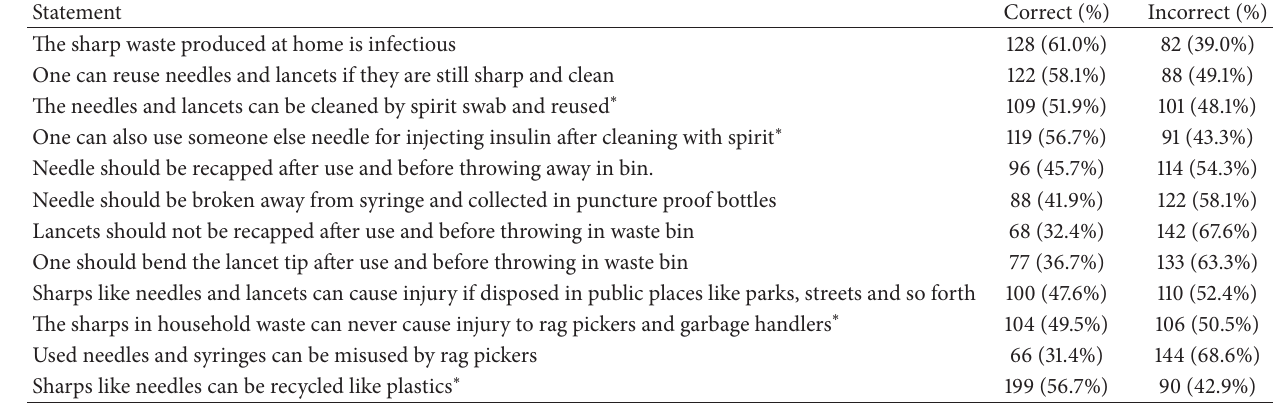
Table 3: Knowledge of respondents towards insulin injection device disposal ( 𝑛 = 210 ).